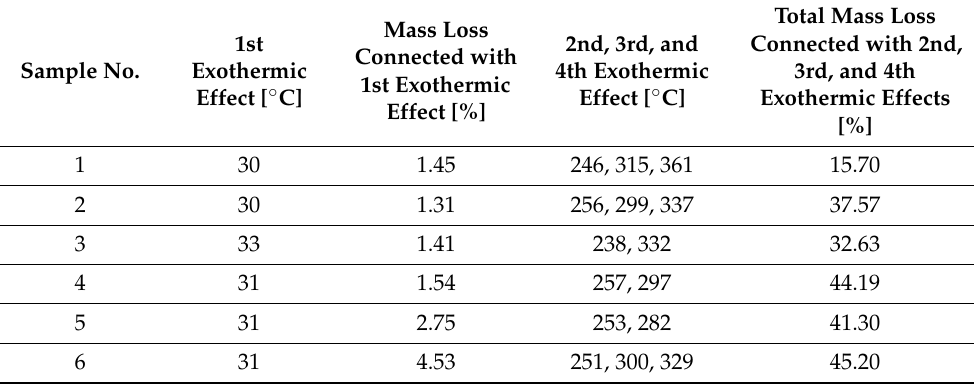
Figure 6. Thermal analysis TG-DTG-DSC of isopropanol-NaOH sample. Table 2. Recorded effects based on thermal analysis.